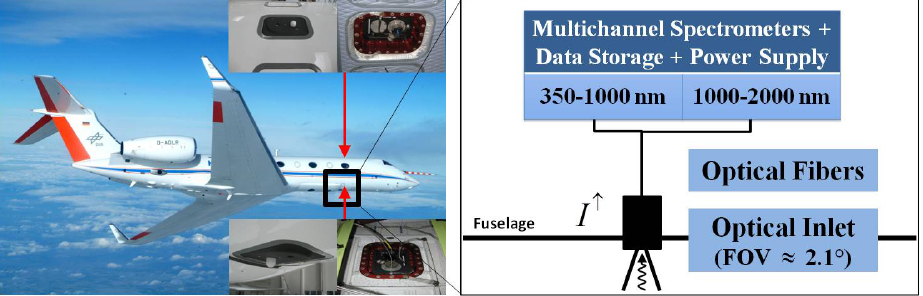
Fig. 1. Illustration of the HALO-SR measurement setup on HALO consisting of an optical inlet (FOV ≈ 2.1 ◦ ), spectrometers and a bifurcated optical fiber that transmits the signal from the optical inlet to two Zeiss multispectral spectrometers monitoring from 350 to